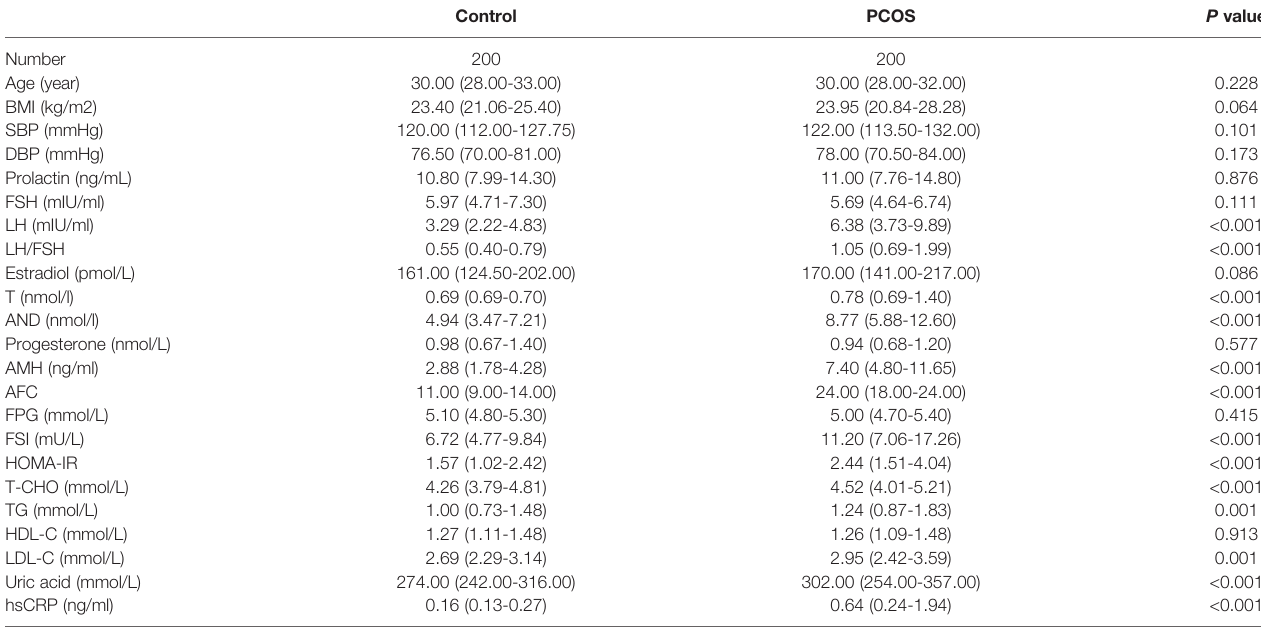
TABLE 1 | The clinical information of polycystic ovary syndrome (PCOS) and control subjects.